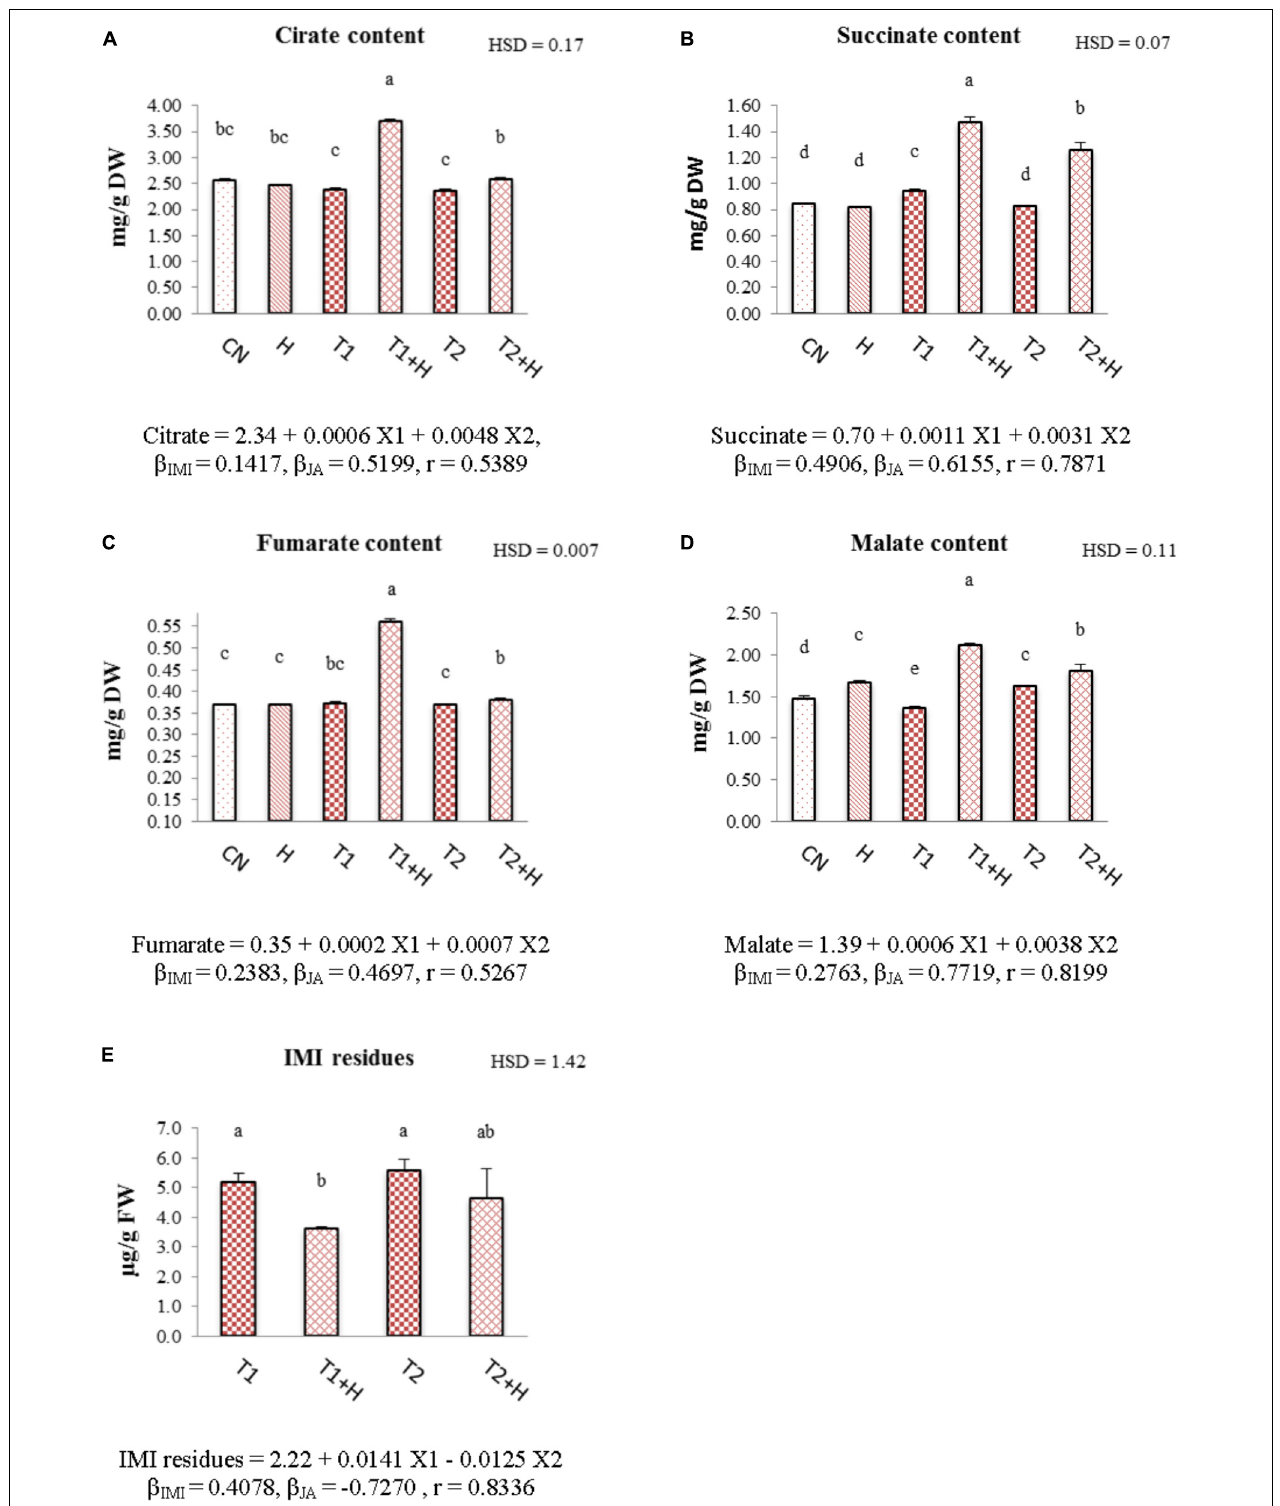
FIGURE 7 | Effect of JA seed soaking on the contents of organic acids and IMI residues in B. juncea seedlings under IMI stress. Data shown here are mean ± SD ( n = 3). Means with same letters are not significantly different from each other, IMI, imidacloprid (X1); JA, jasmonic acid (X2); T1, 200 mg · L − 1 (IMI); T2, 250 mg · L − 1 (IMI); H, 100 nM (JA); r, multiple correlation coefficient. β = β -regression coefficient. A = citrate; B = succinate; C = fumarate; D = malate; E = IMI residues.